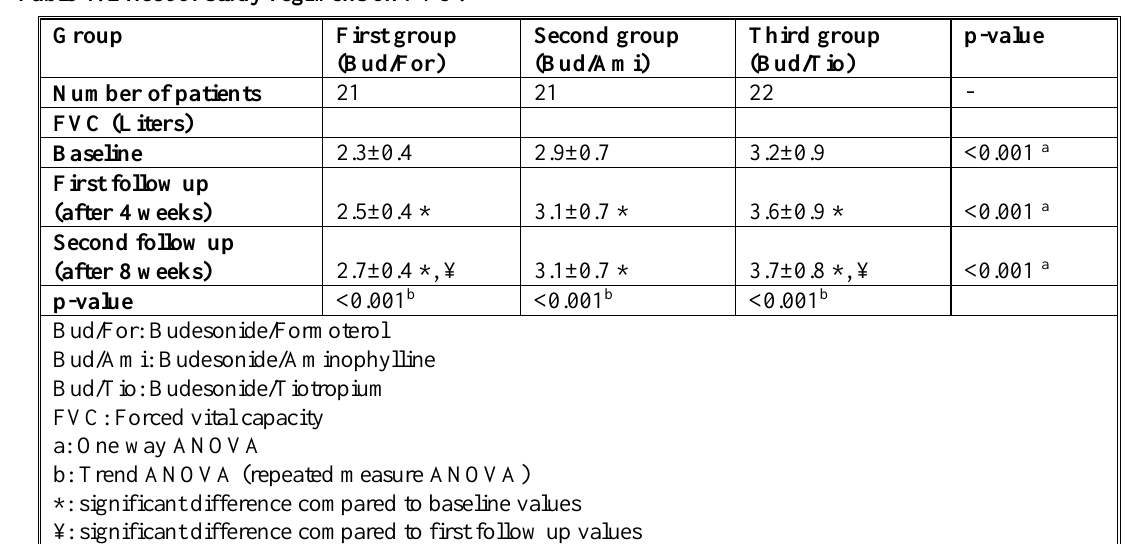
Table 4. Effect of study regimens on